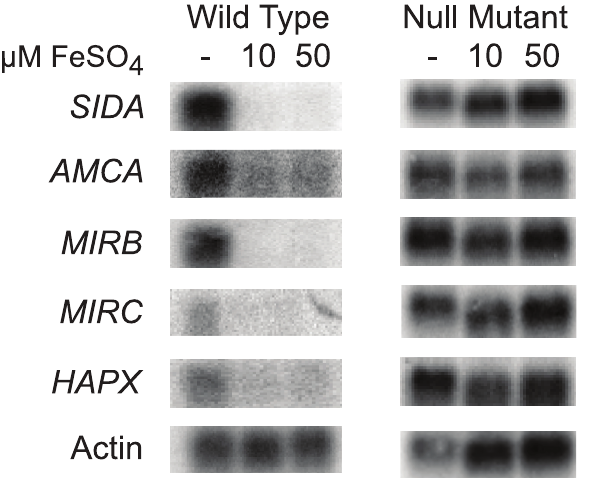
Figure 6. Northern analysis of candidate genes in the SREB regulon involved with siderophore biosynthesis and uptake. Wild-type B. dermatitidis strain 26199 upregulated the expression of SIDA , AMCA , MIRB, MIRC, and HAPX when grown in iron-poor medium (—); expression of these genes was repressed when iron was abundant (10 and 50 m M FeSO 4 ). Deletion of SREB resulted in de-repression of SIDA , AMCA, MIRB, MIRC, and HAPX under iron-replete conditions.